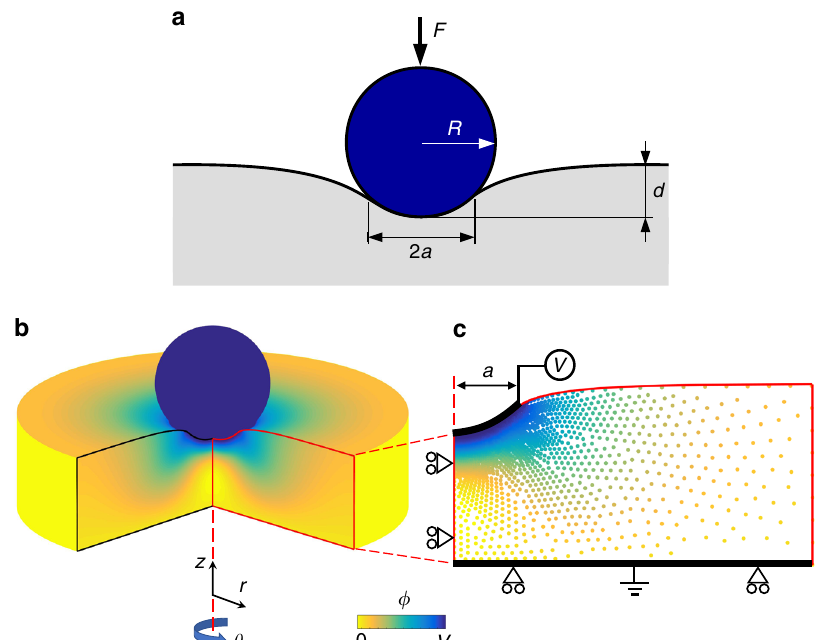
Fig. 1 Schematic of piezoresponse force microscopy measurement. Piezoresponse force microscopy (PFM) operates by delivering a voltage V to the surface of the material via an electrically conducting tip. In a piezoelectric material, the tip voltage V will cause a local deformation, h , which is assumed to stem solely from the piezoelectric coupling. The effective piezoelectric coef fi cient is hence taken as d eff inhomogeneous electric fi eld below the PFM tip, which decays as we move away from the tip. The gradient of this electric fi eld ( ∇ E ) must induce a strain via the converse fl exoelectric effect in all dielectrics, including non-piezoelectrics, see Eq. (1), which results in a measured deformation h , and consequently an apparent piezoelectric coef fi